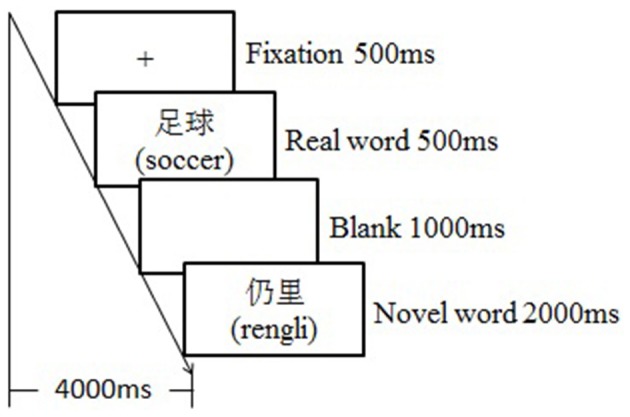
The illustration of testing trial.